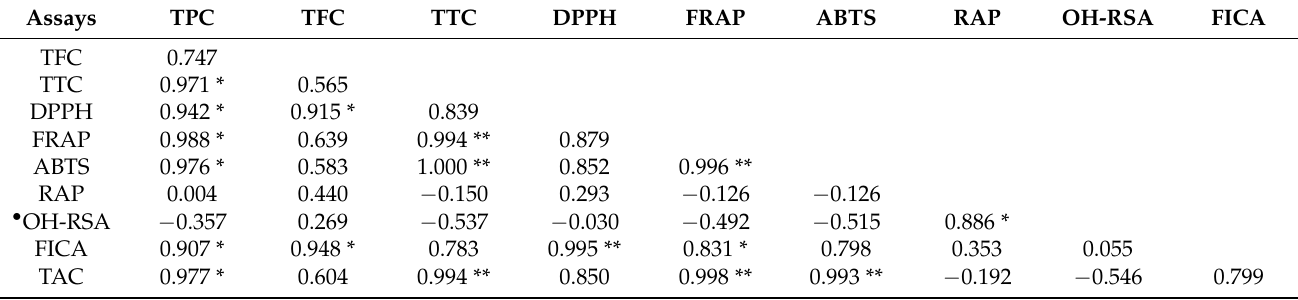
* indicates significant correlation with p ≤ 0.1, while ** indicates highly significant correlation with p ≤